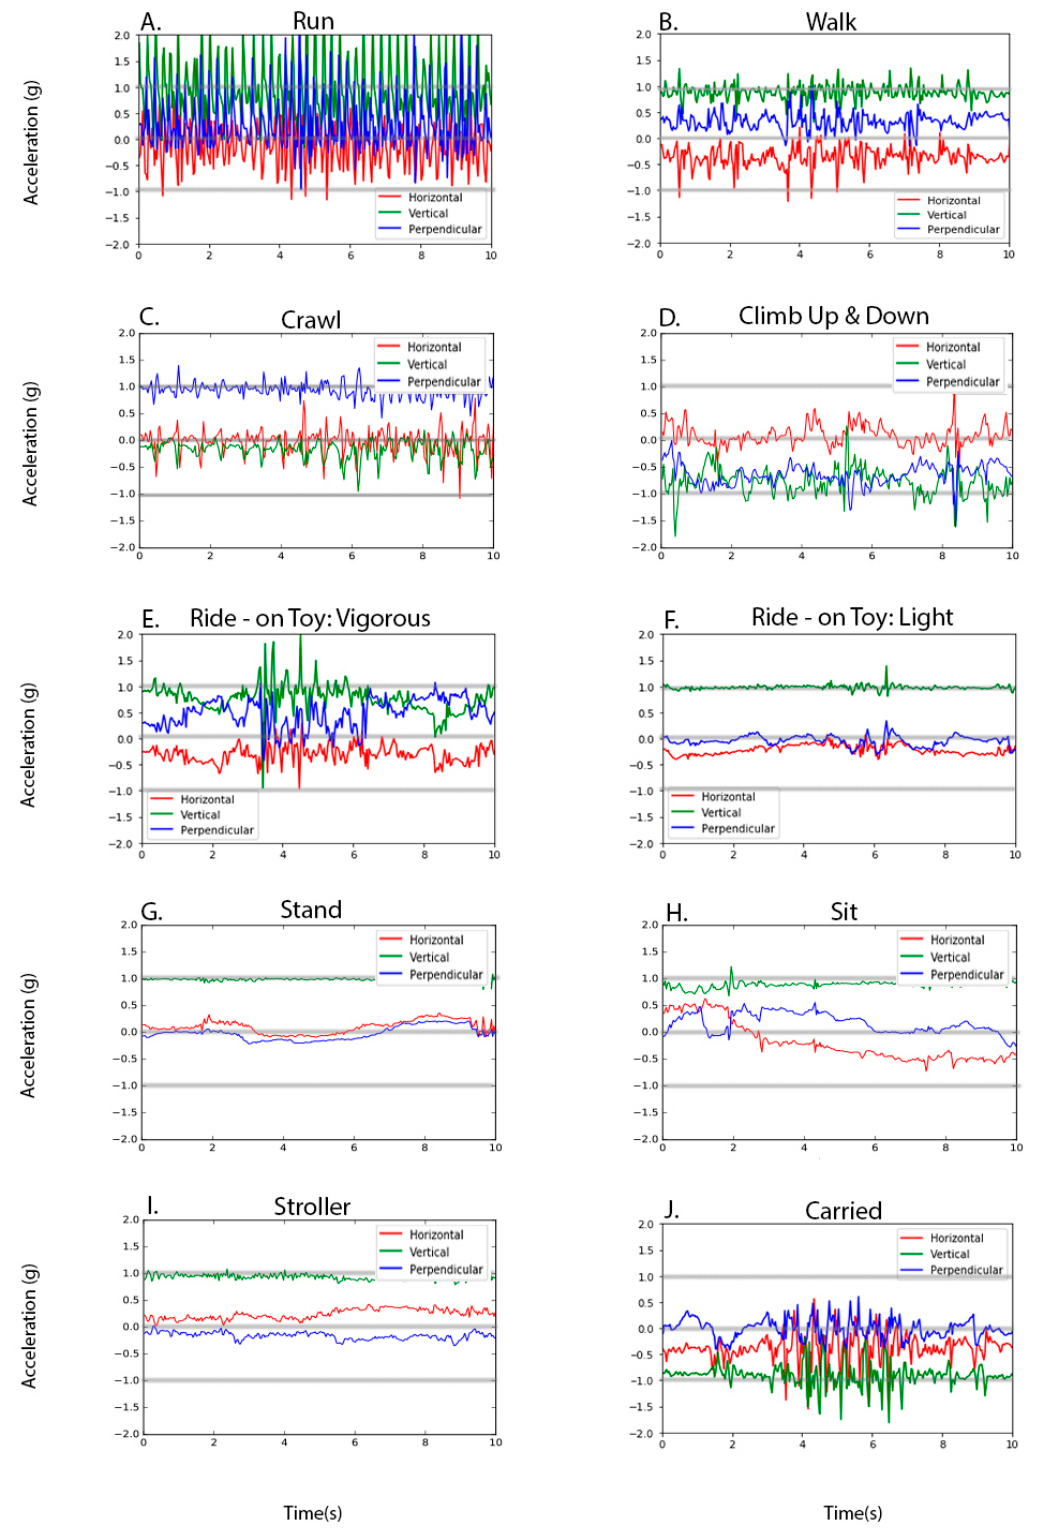
Figure 1. Examples of hip-worn accelerometer signals for various behaviors of toddlers.